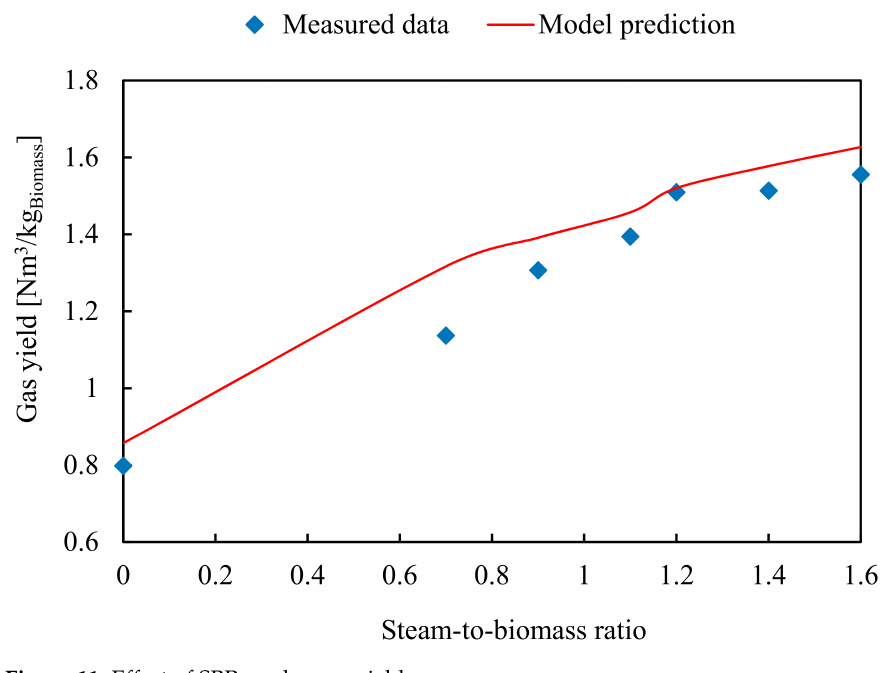
Figure 11. Effect of SBR on dry gas yield.